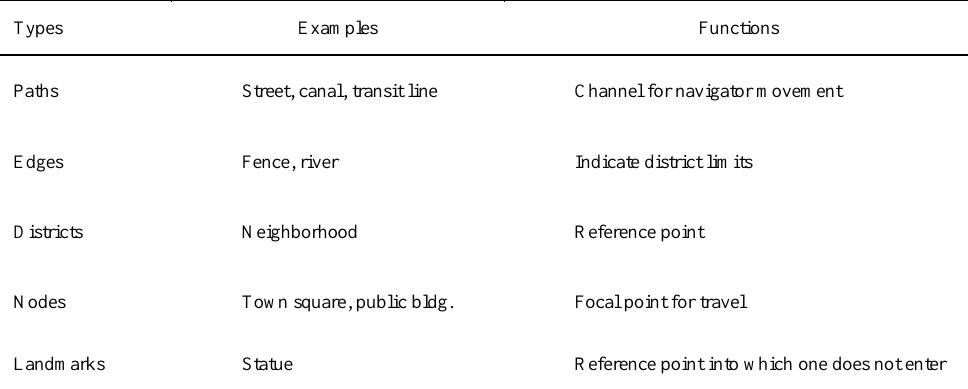
Table1: Landmark/Element Types and Functions (Lynch,